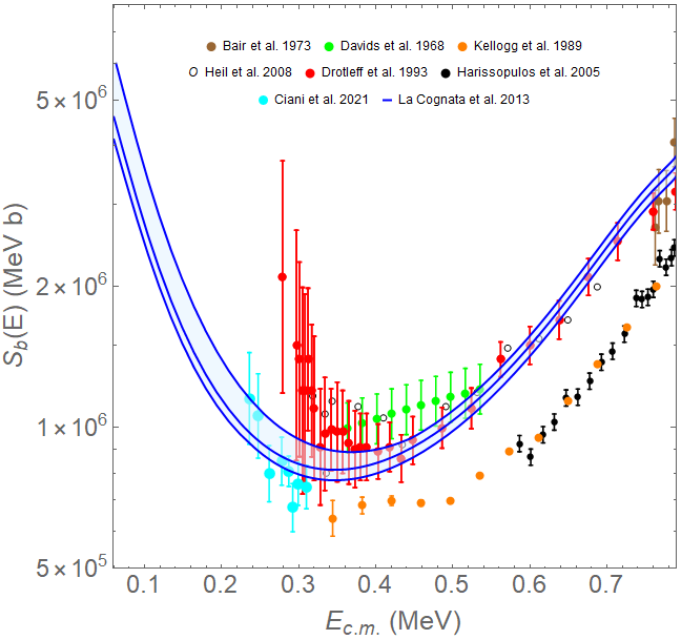
Figure 10. THM S(E)-factor for the 13 C( α ,n) 16 O reaction (blue line and blue band) compared with direct data available in the literature (see text for